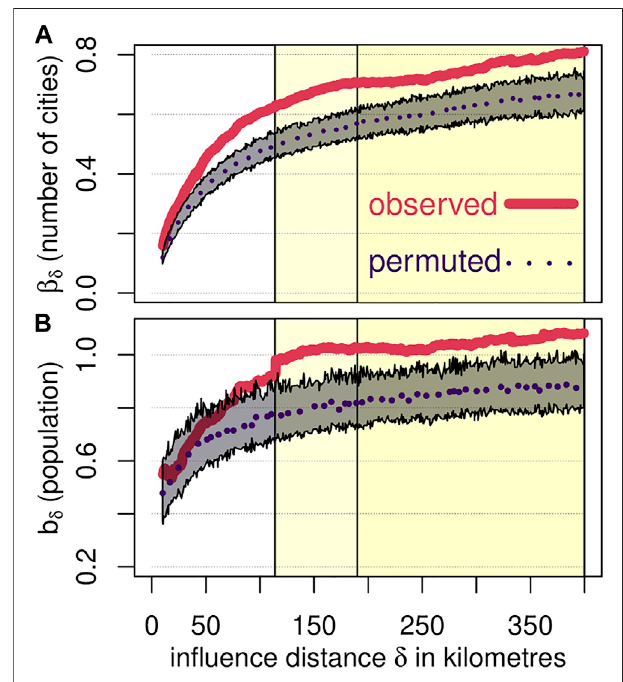
FIGURE 5 | Observed and permuted values of β δ (A) and b δ (B) for the number of cities and the population in the region of in fl uence of cities. The horizontal axis is the in fl uence distance δ in kilometres. The red lines are the observed values, and the purple line and the shaded interval around the permuted results give the range of values obtained from the permuted network. Intervals are obtained for a fi xed value of δ by permuting 100 times the population size of cities and removing the top 5 and the bottom 5 simulated values to drop